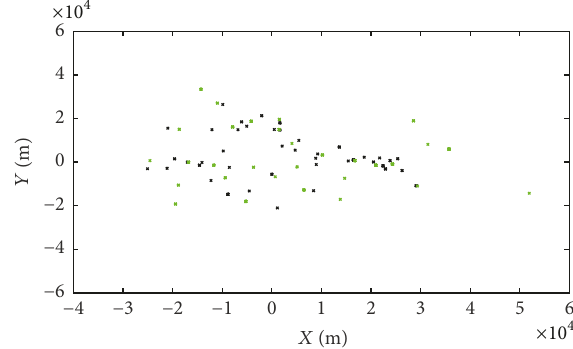
Figure 11: Contrast figure of the CB origin distribution.